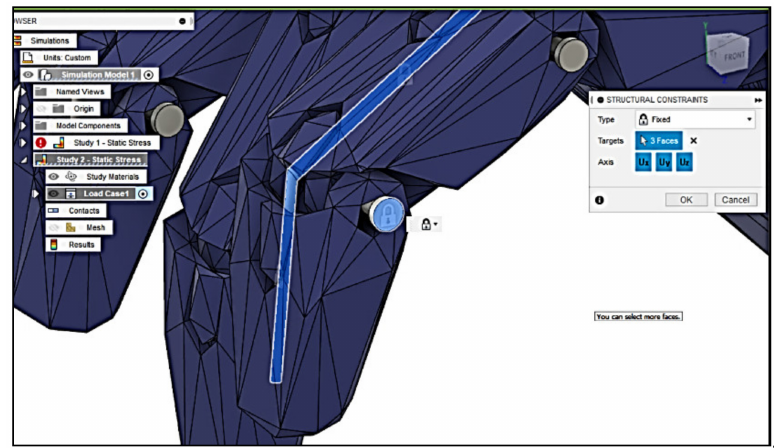
Figure 11. Demonstration of the fixation constants of acting forces.